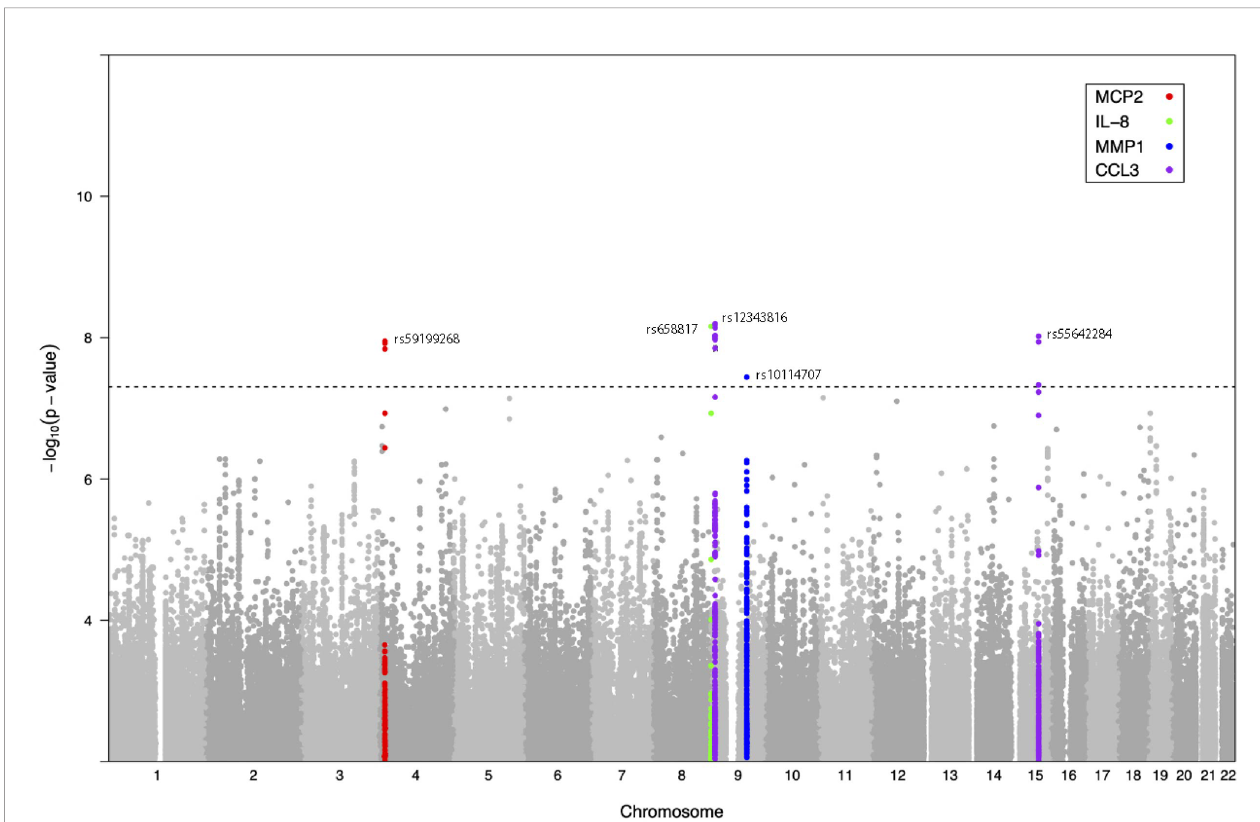
FIGURE 2 | Genome-wide protein-QTL mapping identi fi ed fi ve C. albicans yeast-induced pQTLs. Manhattan plot showing the genome-wide QTL mapping results for C. albicans -induced MCP-2 (red), IL-8 (green), MMP-1 (blue), and CCL3 levels (purple). The y-axis represents the negative log 10 P values of pQTLs. Their chromosomal positions are shown on the x axis. The horizontal dashed line represents the genome-wide signi fi cance threshold for association ( P < 5 x 10 -8